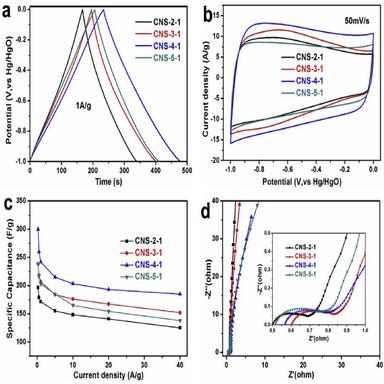
Electrochemical characterization of the CNS-X-1 (X ¼ 2, 3, 4, 5) as electrode materials with three-electrode configuration at 6 M KOH electrolyte. a) GCD curves for different CNS-X-1 (X ¼ 2, 3, 4, 5) measured at 1A g1 . b) CV curves for the CNS-X-1 (X ¼ 2, 3, 4, 5) measured at 50 mVs1 . c) The specific capacitance of the electrodes as various current densities. d) The Nyquist plots of all samples. (A colour version of this figure can be viewed online.)